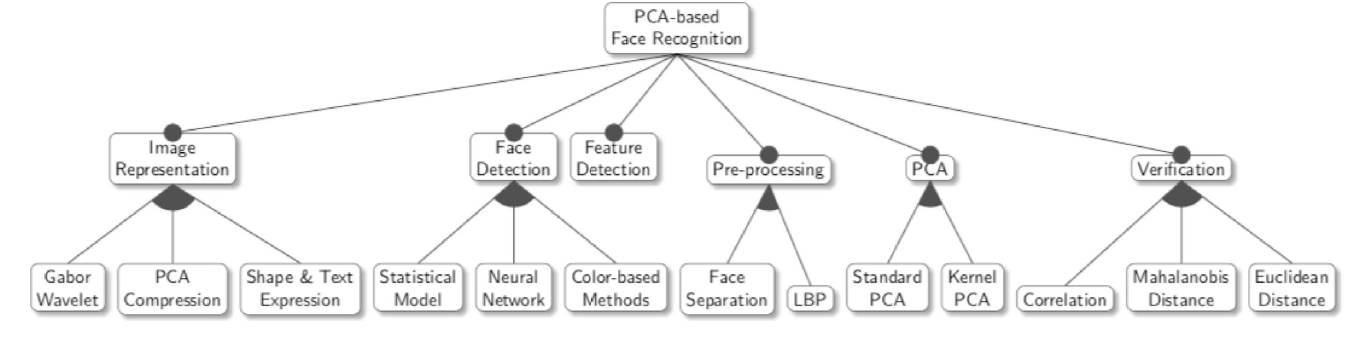
Fig 8. Framework as a feature